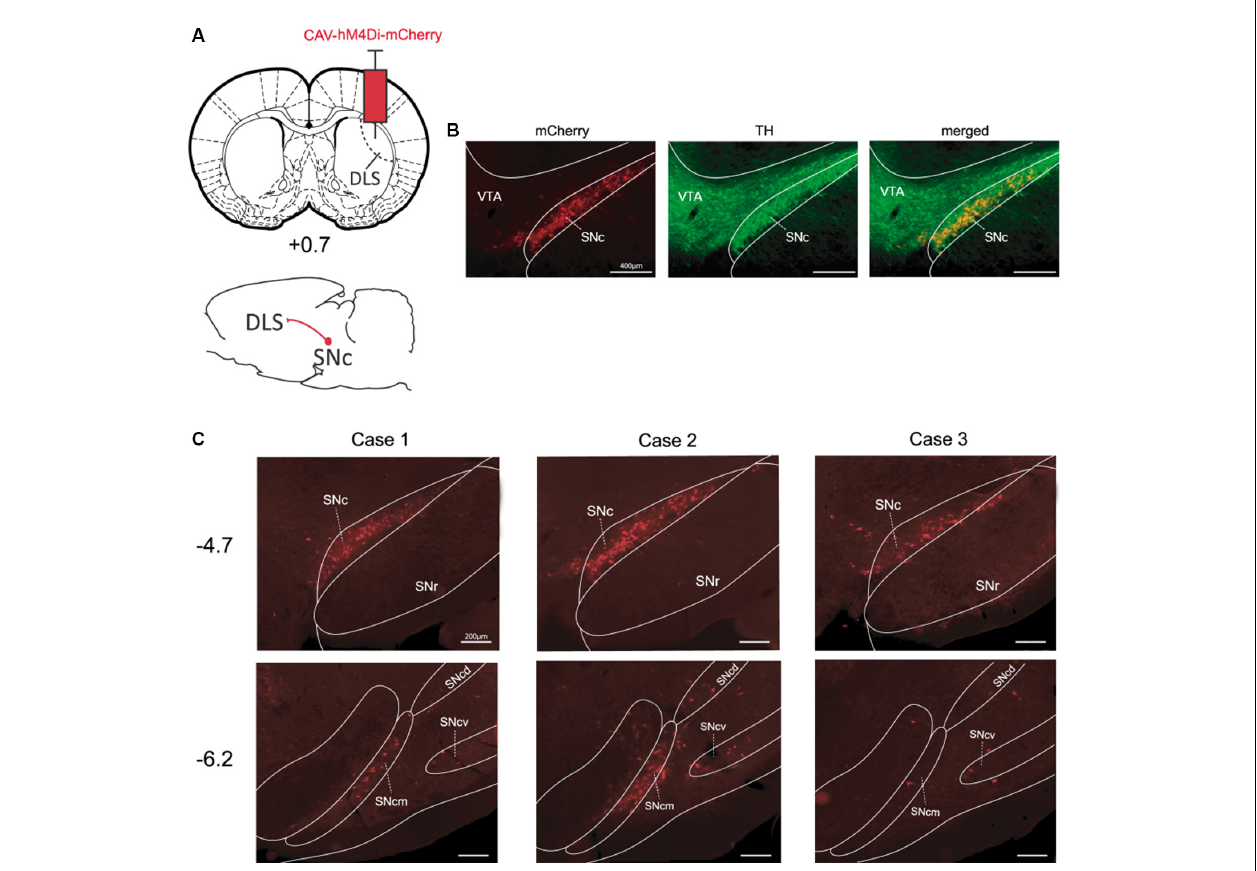
FIGURE 1 | Targeting the nigrostriatal pathway with CAV-hM4Di (A) Schematic illustration of viral vector injection into the dorsolateral striatum (DLS) to selectively infect nigrostriatal neurons. (B) Example of staining obtained in the SNc vs. the VTA for mCherry-positive and tyrosine hydroxylase (TH)-positive neurons [Case 2, anteroposterior (AP) − 4.7 mm]. (C) The rostrocaudal extent of staining in SN for all pilot cases at coordinates AP − 4.7 mm and AP − 6.2 mm (from Bregma). DLS, dorsolateral striatum; SNc, substantia nigra pars compacta; SNcm, d, v: substantia nigra pars compacta, medial tier, dorsal tier, and ventral tier respectively; VTA, ventral tegmental